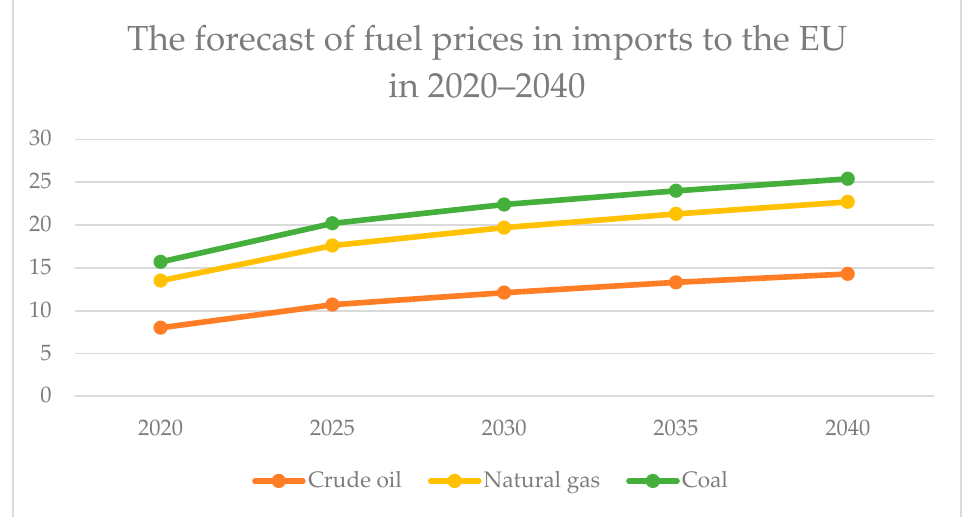
Figure 8. The forecast of fuel prices in imports to the EU in 2020–2040 [EUR’2016/GJ]. Source: authors’ own studies, developed from [42].